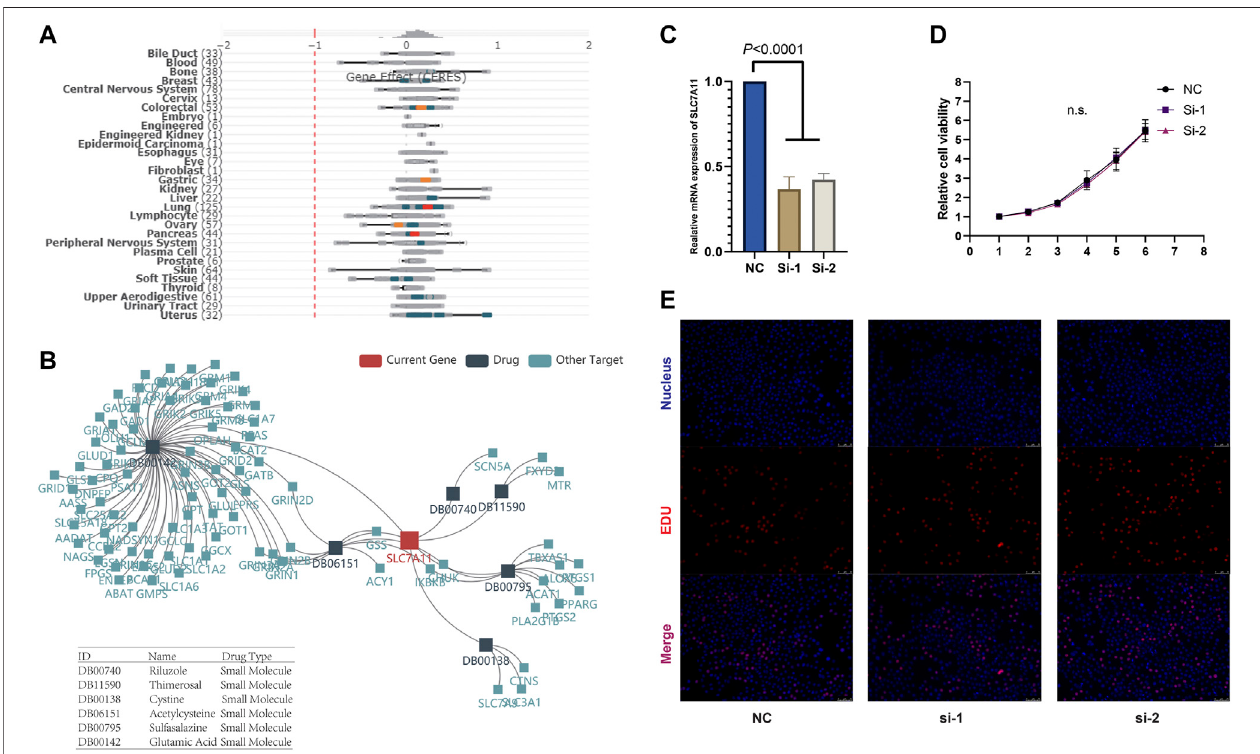
FIGURE 4 | (A) SLC7A11 expression barely affects tumor cell proliferation in vitro . (B) SLC7A11 expression is associated with the sensitivity to multiple drugs. (C) Knockdown of SLC7A11. (D, E) CCK-8 and EDU analysis shows there are no obvious changes in cell proliferation after SLC7A11 knockdown in panc-1